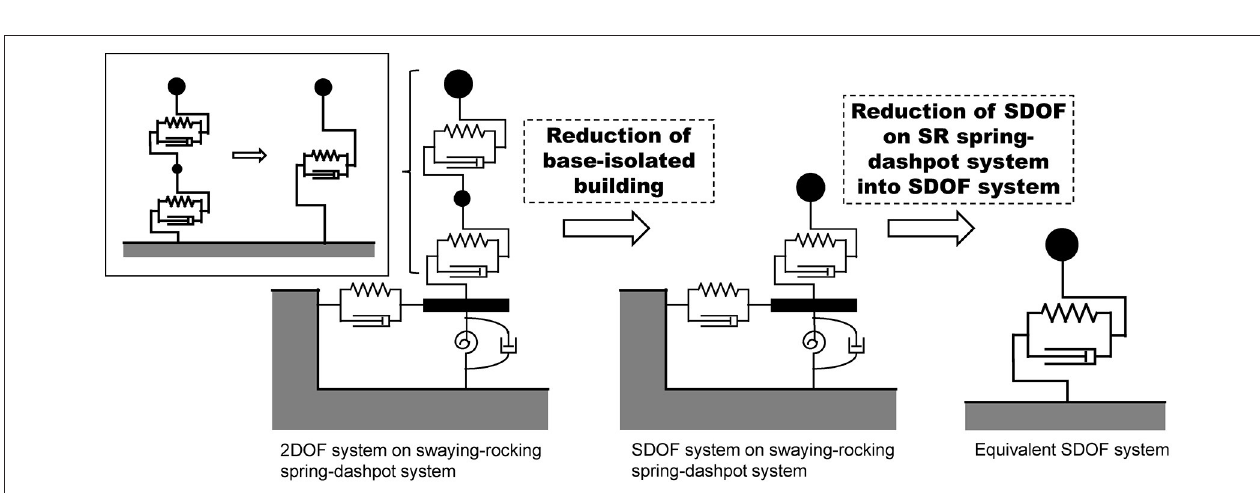
FIGURE 4 | Transformation of total system into an SDOF system through two-stage procedure.